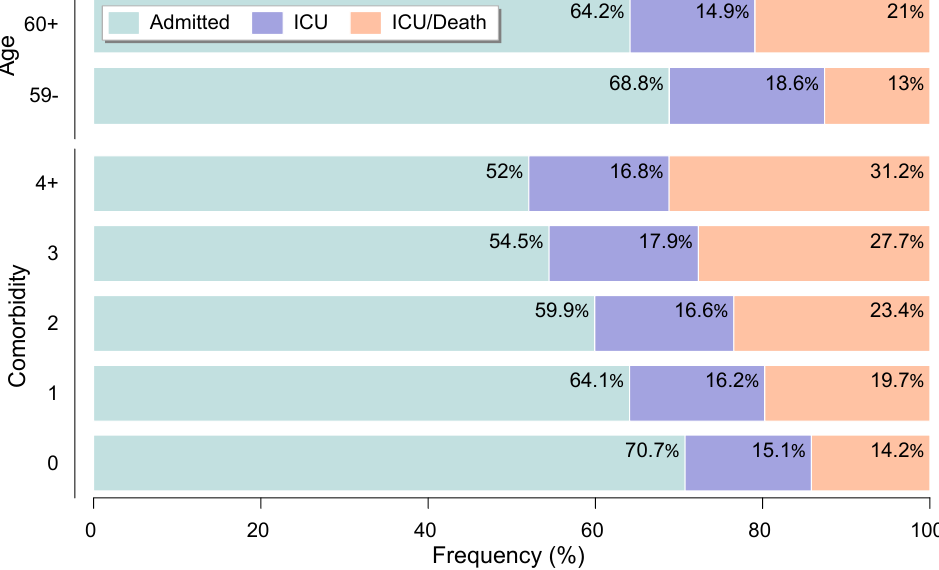
Figure 2. COVID-19 hospitalizations, intensive care unit (ICU) admissions, and deaths, by age groups and